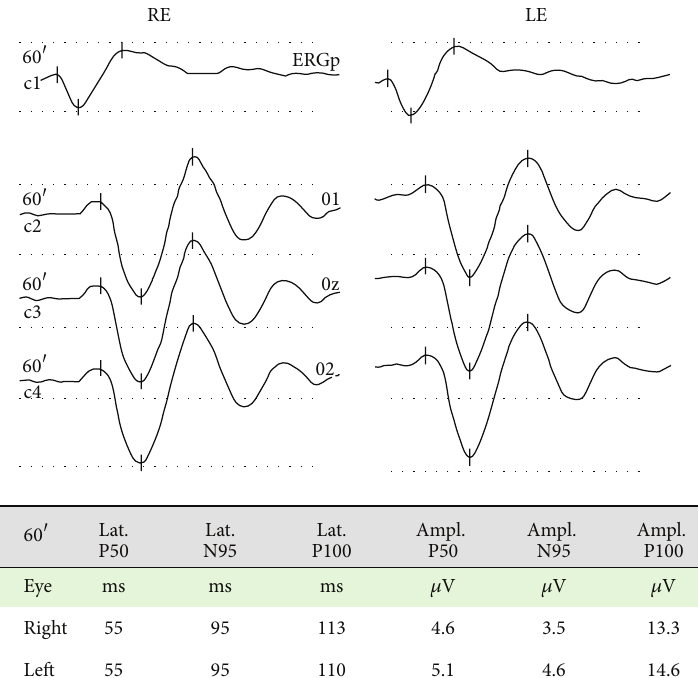
Figure 3: Pattern ERG-VEP recording of the patient, showing normal values of latencies and amplitudes of the different components. LE: left eye. RE: right eye.